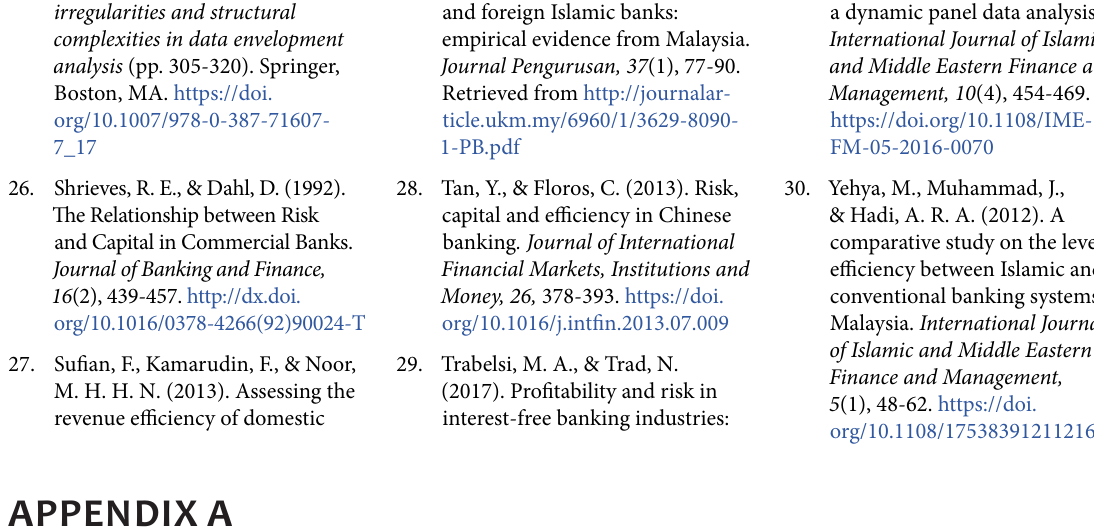
Table 1A. The study sample